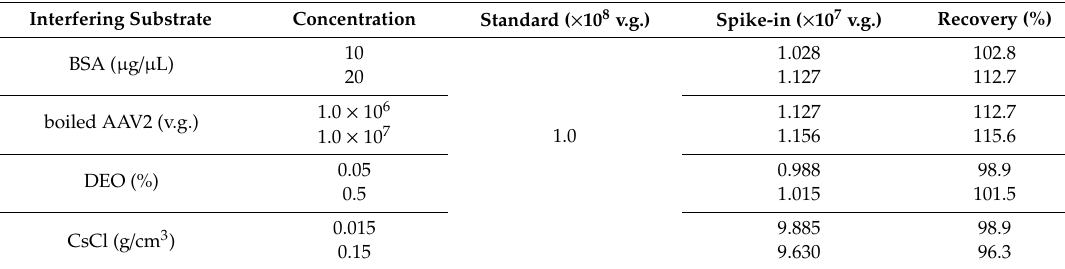
Table 4. Selectivity of